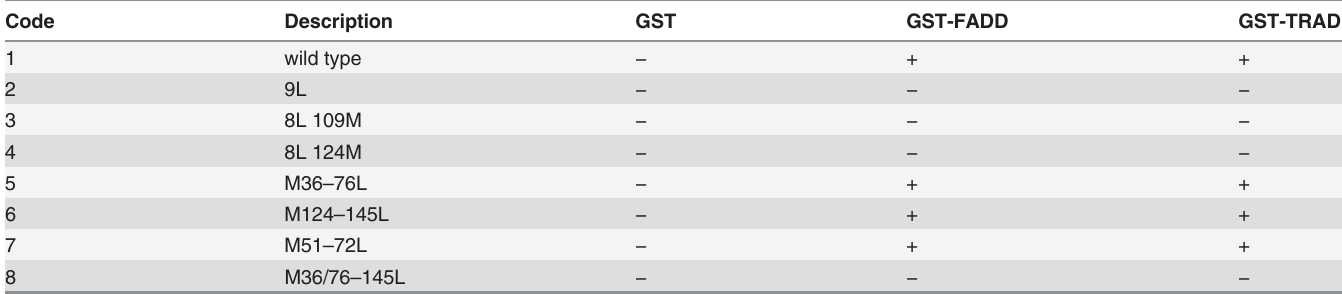
Table 2. Binding assays of Met-to-Leu CaM